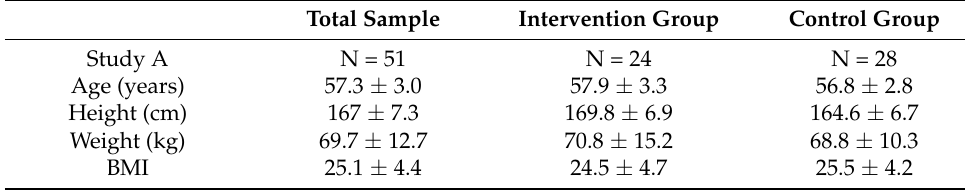
Table 2. Anthropometric data with mean and standard deviation—Study A.